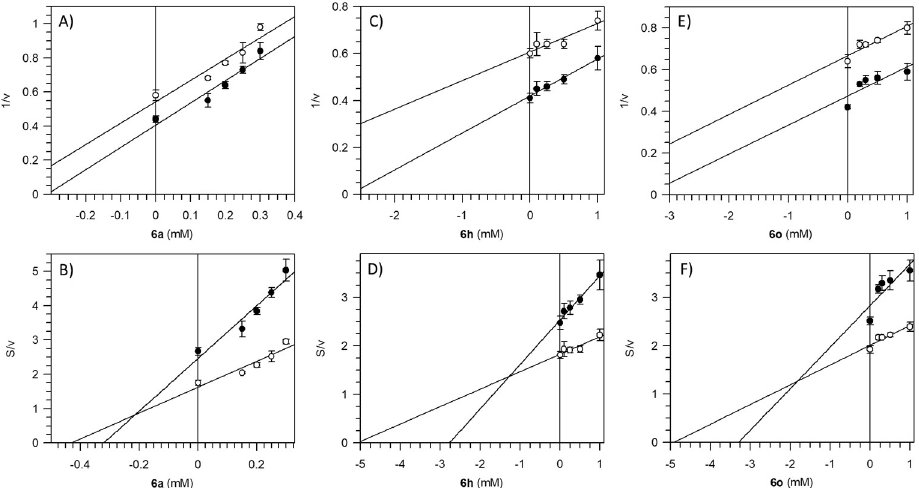
Figure 4. Mitochondrial F 1 F O -ATPase inhibition by Pzs. Dixon ( A , C , E ) and Cornish-Bowden ( B , D , E ) plots were obtained at two fixed ATP concentrations and designing the experiments as detailed in the “Kinetic analysis” section of Materials and Methods. All points represent the mean ± SD (vertical bars) of three independent experiments carried out on different mitochondrial preparations.